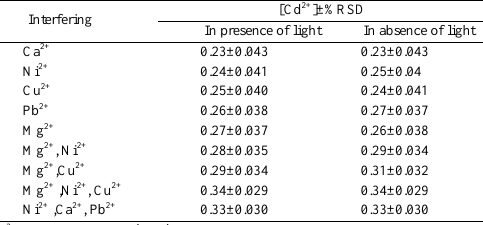
Table 4. Investigation of interfering ions effect at concentration level of removal of 2 mg/l cadmium (II) ion (Initial concentration was 200 mg/l) by Ce-TiO2/bentonite nanocomposite